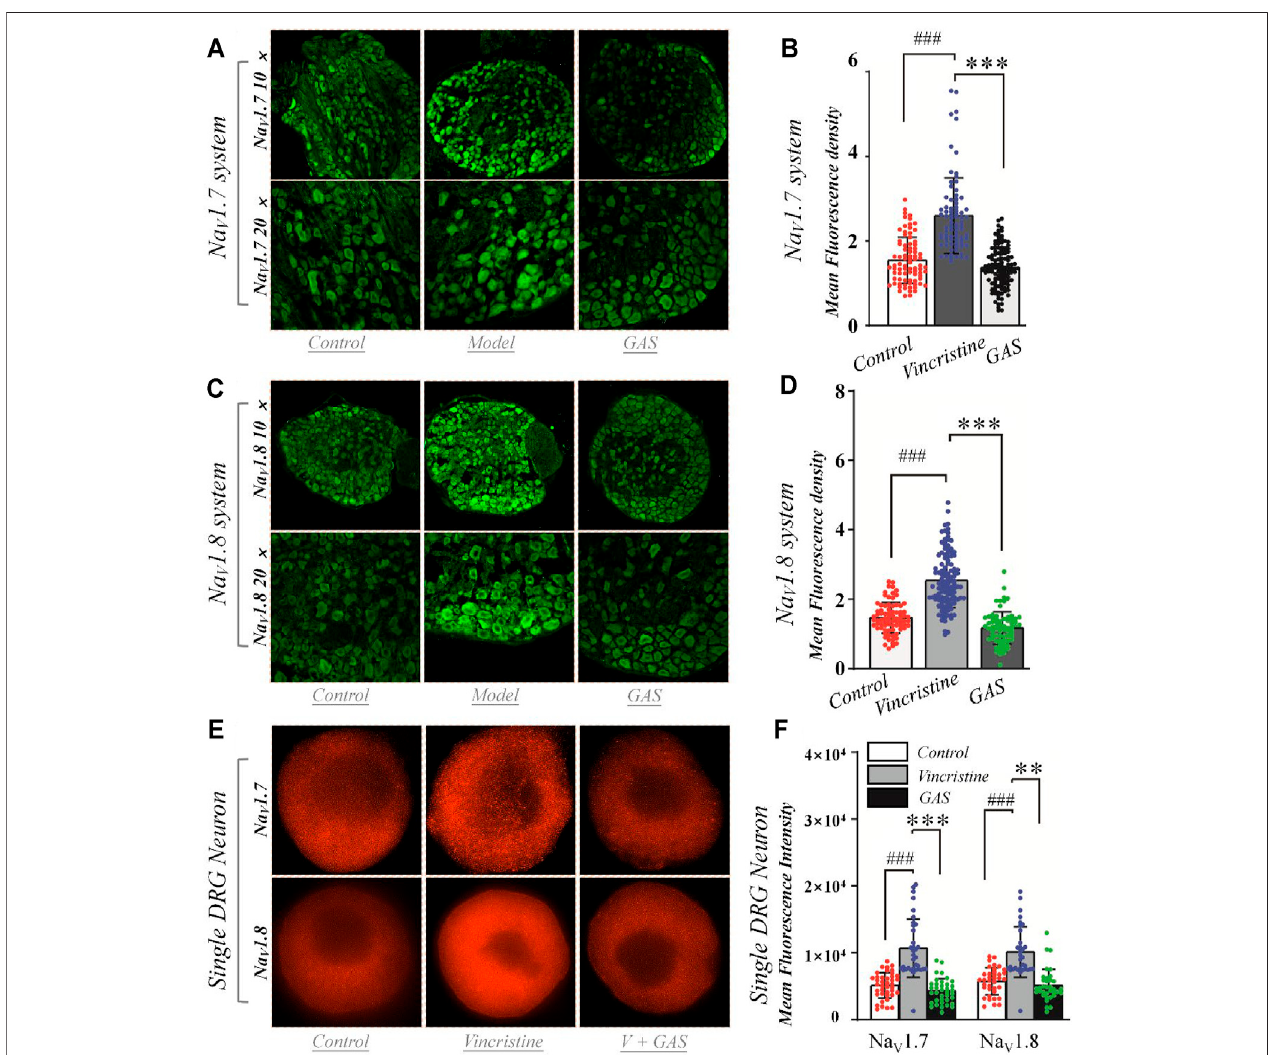
FIGURE 6 | Effects of GAS on the expression of Na V 1.7 and Na V 1.8 channel proteins in DRG neurons: (A) typical diagram of the effects of GAS on Na V 1.7 protein expressioninDRGganglion; (B) theeffectsofGASontheaverage fl uorescencedensityofNa V 1.7proteininDRGtissue(control: n (cid:1) 82,vincristine: n (cid:1) 80,GAS: n (cid:1) 115, N (cid:1) 4,5,5); (C) typicaldiagramoftheeffectsofGASonNa V 1.8proteinexpressioninDRGganglion; (D) theeffectsofGASontheaverage fl uorescencedensityofNa V 1.8 proteininDRGtissue(control: n (cid:1) 79,vincristine: n (cid:1) 120,GAS: n (cid:1) 74,N (cid:1) 4,5,4); (E) SIMimageofthedistributionofNa V 1.7andNa V 1.8proteinandthedepiction ofintensity; (F) histogramofthein fl uenceofGASon fl uorescenceintensityofNa V 1.7protein(control: n (cid:1) 40,vincristine: n (cid:1) 33,GAS: n (cid:1) 37)andNa V 1.8(control: n (cid:1) 37, vincristine: n (cid:1) 32, GAS: n (cid:1) 35) (### p < 0.001, compared to the control group; **p < 0.01, ***p < 0.001 compared to the model group; ANVOA- Bonferroni Test).